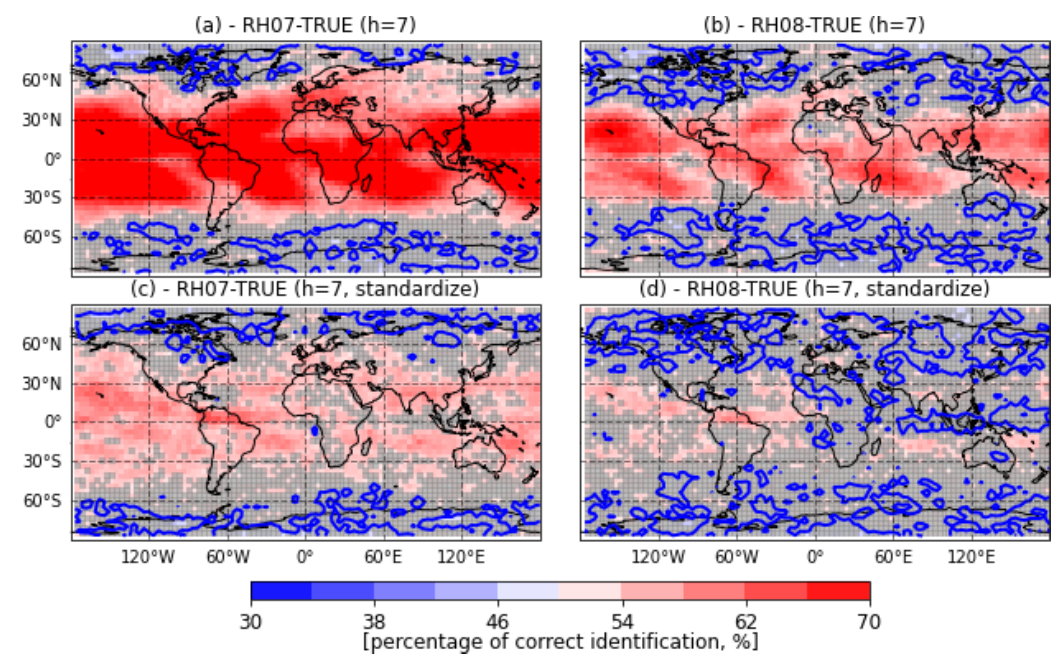
Figure 10. Percentage of correct identification based on the CME for a 7d evidence window between the RH07 and TRUE catalog (a, c) and between the RH08 and TRUE catalogs (b, d) using AnDA. The percentage of correct identification is computed assimilating temperature observations or their standardized values ( a and b , c and d , respectively). The gray shade indicates values which are below the 95% statistical significance level. The blue lines correspond to a 50% of correct identification.